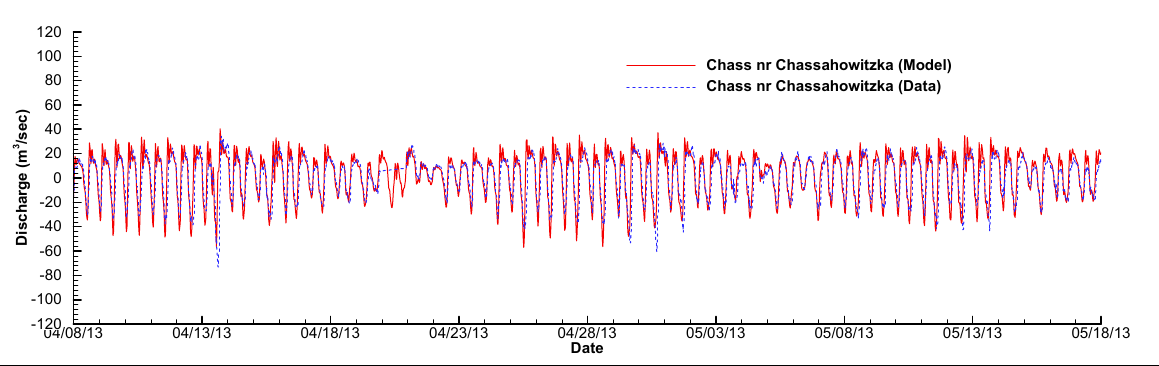
Figure 10. Comparison of measured and simulated discharge at the CRC station from 8 April 2012 through 18 May 2013.